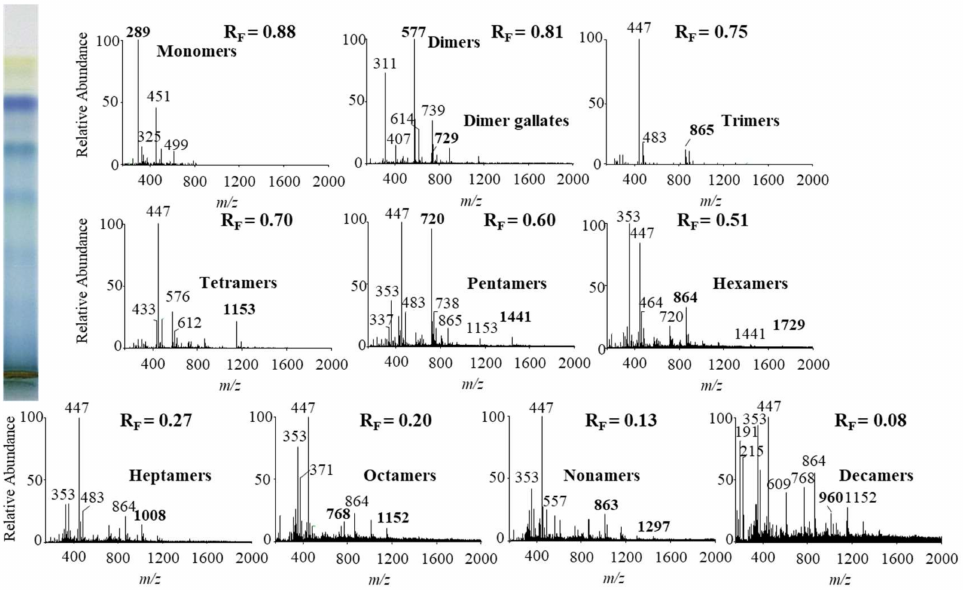
Figure 8. MS spectra obtained by HPTLC-MS analyses of STS from Japanese knotweed leaves on HPTLC diol F 254S plate pre-developed and developed with acetonitrile. The bolded m / z values in the MS spectra belong to B-type proanthocyanidins and their gallates, which were eluted from the plate with acetonitrile–methanol (2:1, v / v ). A part of the plate was derivatized with DMACA